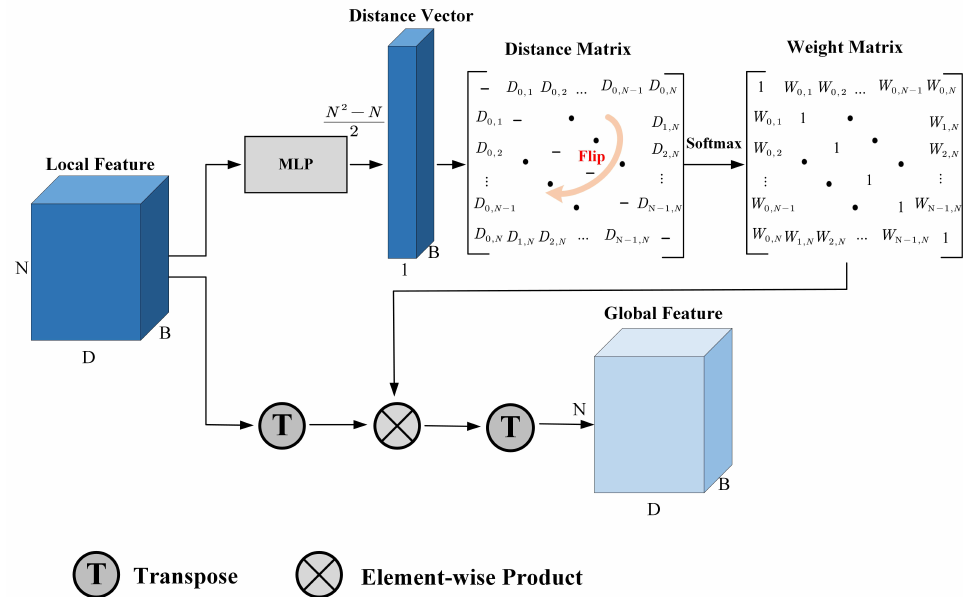
Figure 5. The structure of GGFA. For better visualization, we add the batch dimension B to the local feature, performing in a three-dimensional manner. N represents the number of pixels in each anchor line, which is equal as H F . D is the feature dimension, which is equal as ˆ C